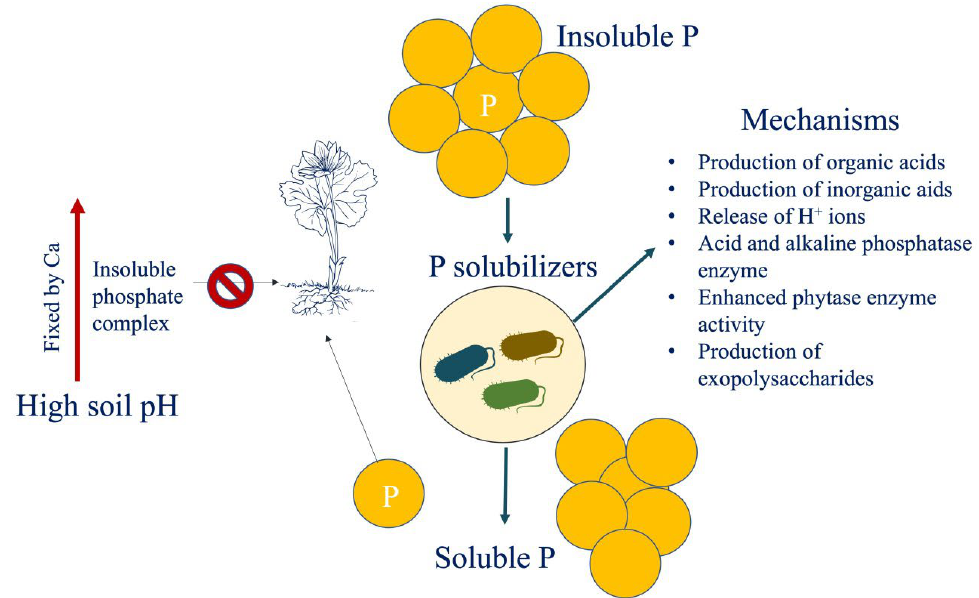
Figure 3. Implication of phosphorus (P) solubilizing microbes for improving phosphorus use effi- ciency in arid soils.